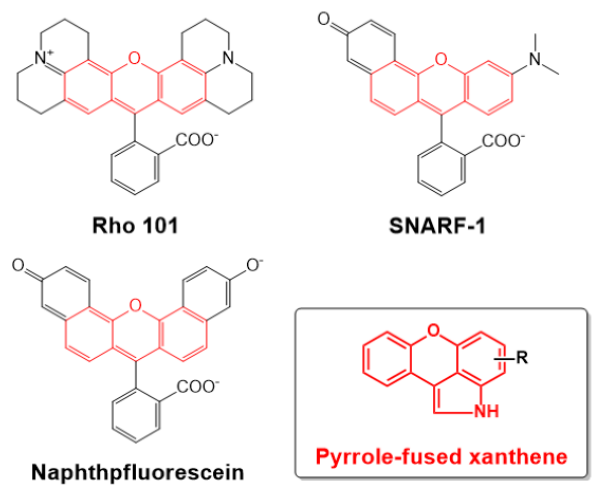
Figure 1. The fluorophores based on xanthene moiety.